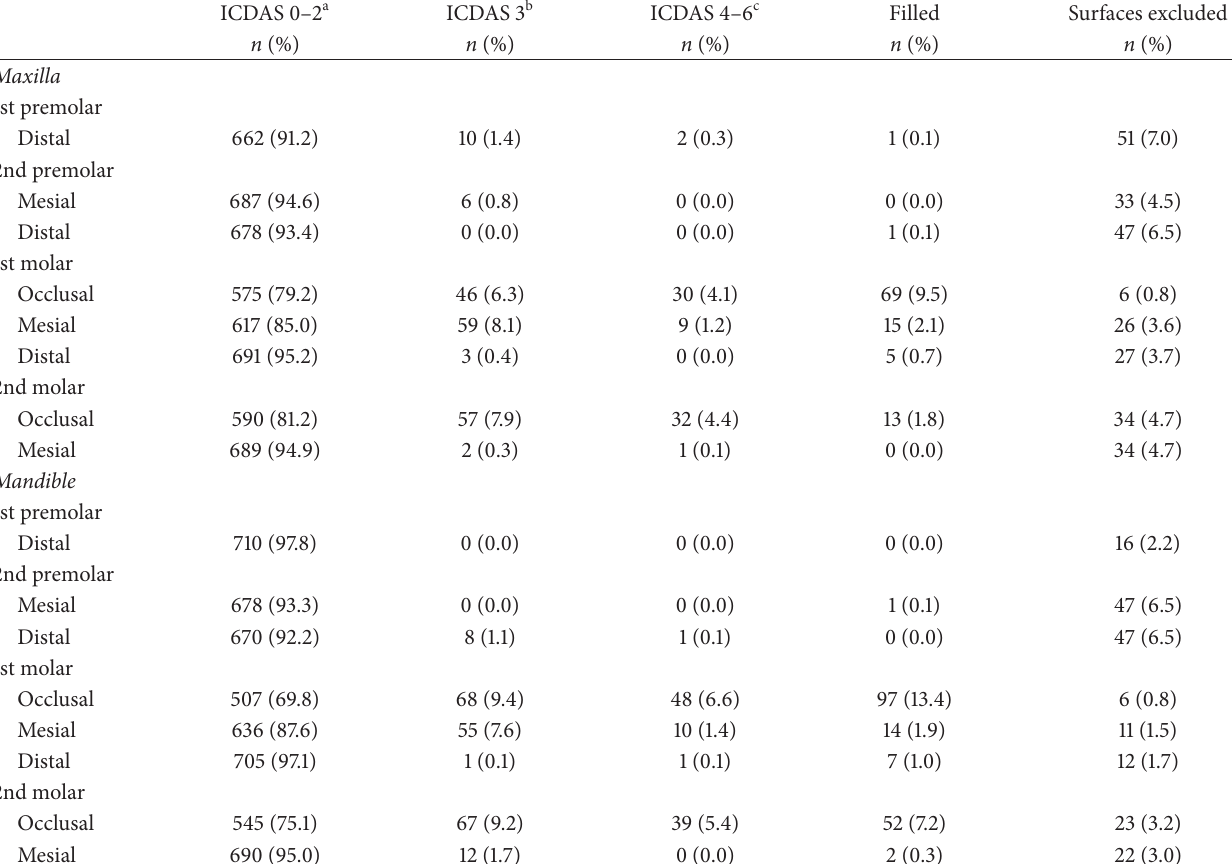
Table 1: Number and percentage of surfaces with different stages of decay in clinical examination by tooth and